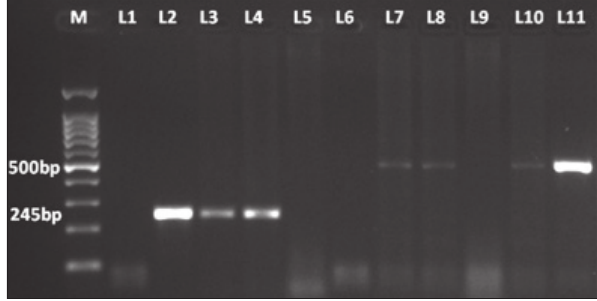
Figure-1: Amplification of DNA from the samples using INS1/INS2 primers and JB21/JB22 (M: 100 bp plus molecular weight marker, L1: Negative control, L2: Positive control for Mycobacterium tuberculosis complex (MTC), L11: Positive control for Mycobacterium bovis , L3 and L4: Samples positive for MTC, L7, L8 and L10: Samples positive for M. bovis , L5, L6 and L9: Samples